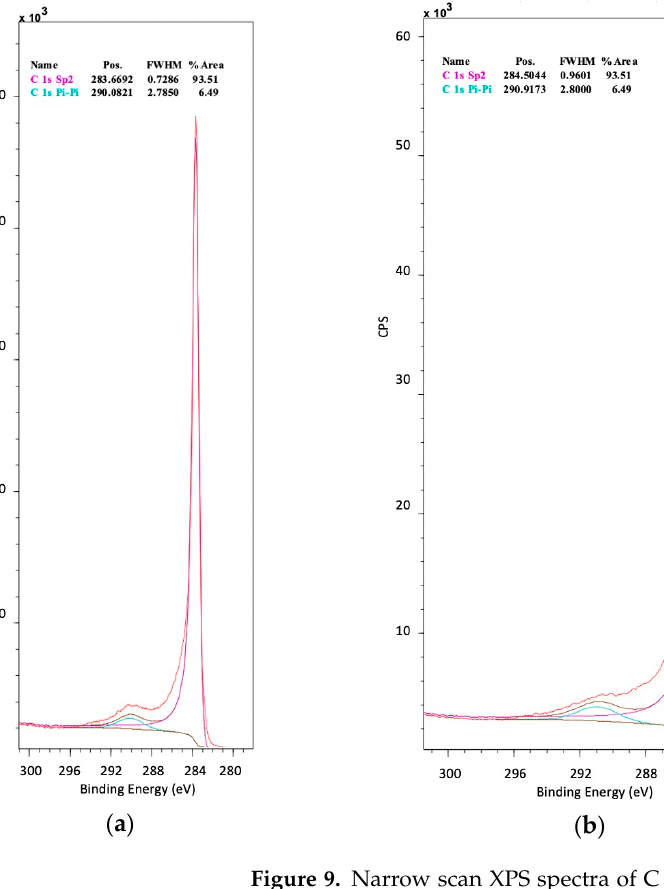
Figure 9. Narrow scan XPS spectra of C 1s of different synthesized photocatalysts and supports: ( a ) N 1 /TiO 2 /CNT, ( b ) N 10 /rGO, ( c ) N 1 /TiO 2 /rGO.